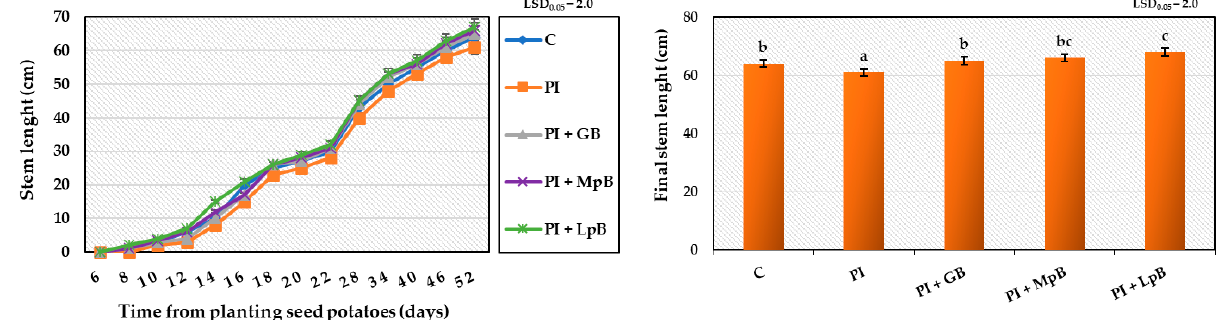
Figure 4. The kinetics of stem growth and their final length after 52 days from planting Impresja